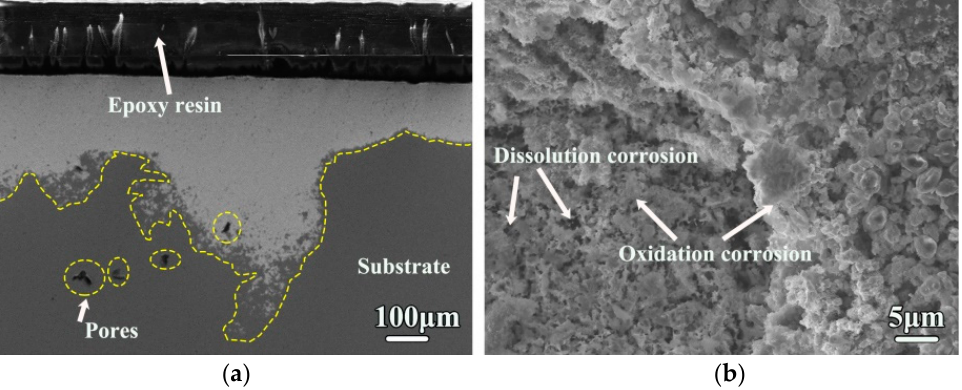
Figure 9. EDS line scanning of the AlTiCrFeMoSi HEA coating exposed to LBE at 550 °C for 500 h.